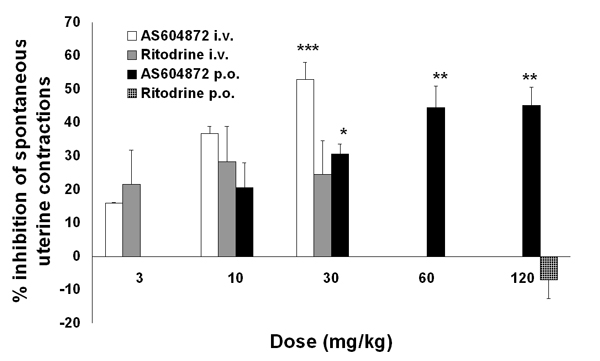
Effects of AS604872 and ritodrine on inhibition of spontaneous uterine contractions in pregnant rats. Anesthetized late-term pregnant rats at gestational days 19–21 were treated with AS604872 or ritodrine either by intravenous route as a 10-min infusion or orally as a single dose. The inhibition of spontaneous uterine contractions is represented in function of the dose of drugs. N = 8 animals per dose and route and drug. *p < 0.05, **p < 0.01 and ***p < 0.001 vs vehicle-treated group (one-way ANOVA followed by Tukey test).